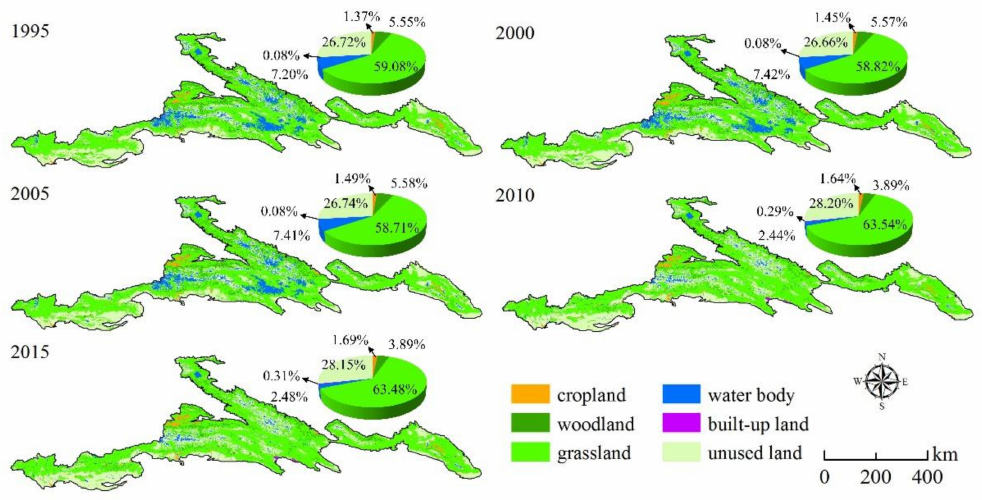
Figure 3. The land-use change from 1995 to